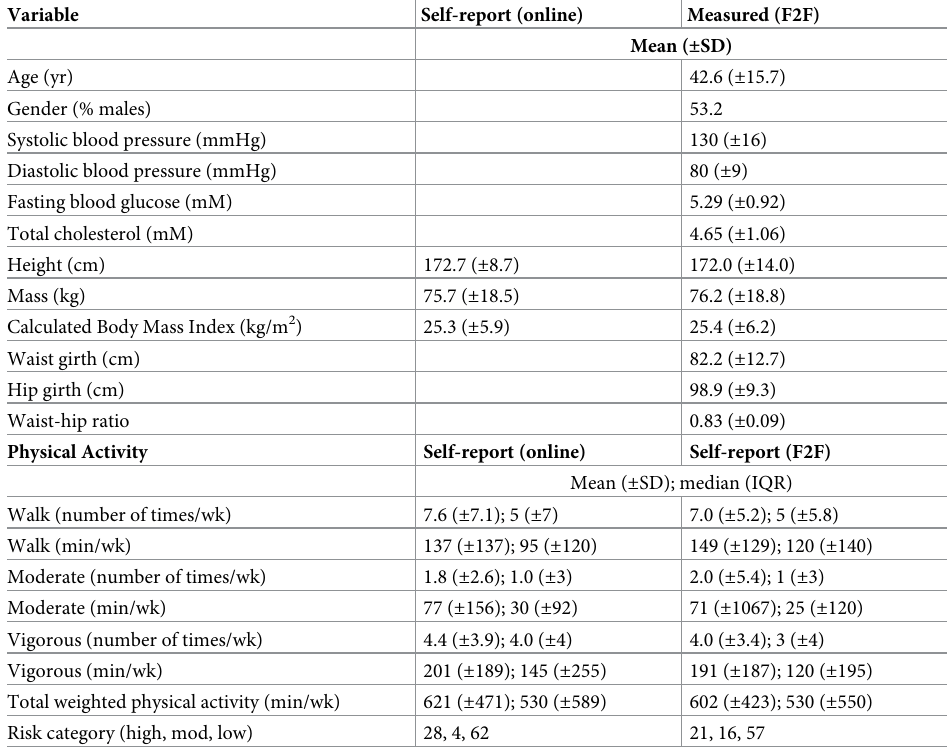
Table 1. Descriptive data for major health risk factors and physical activity behaviours for the 94 participants based on the APSS. Values are shown as mean ( ± standard deviation); and/or median ( ± inter-quartile range).